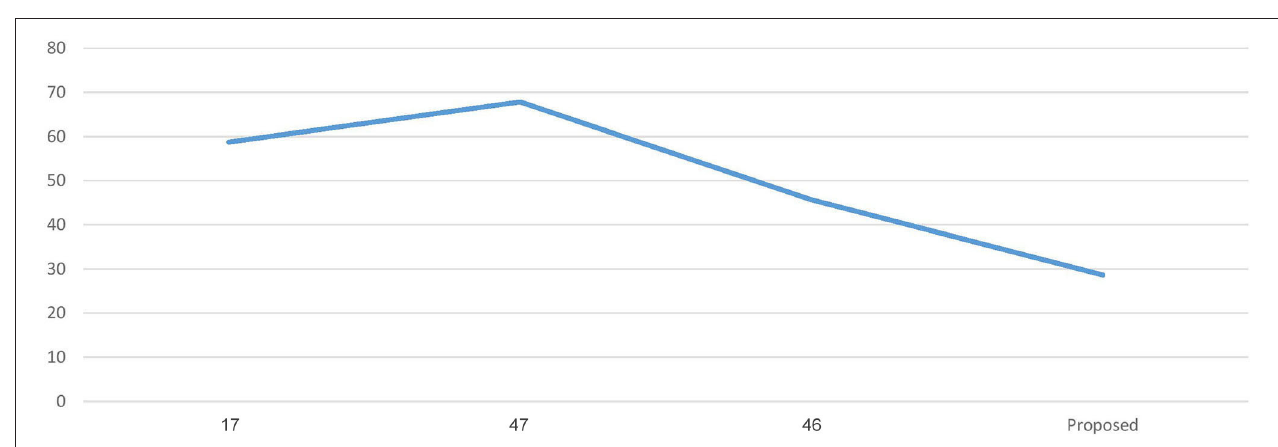
FIGURE 6 | Comparison of computation